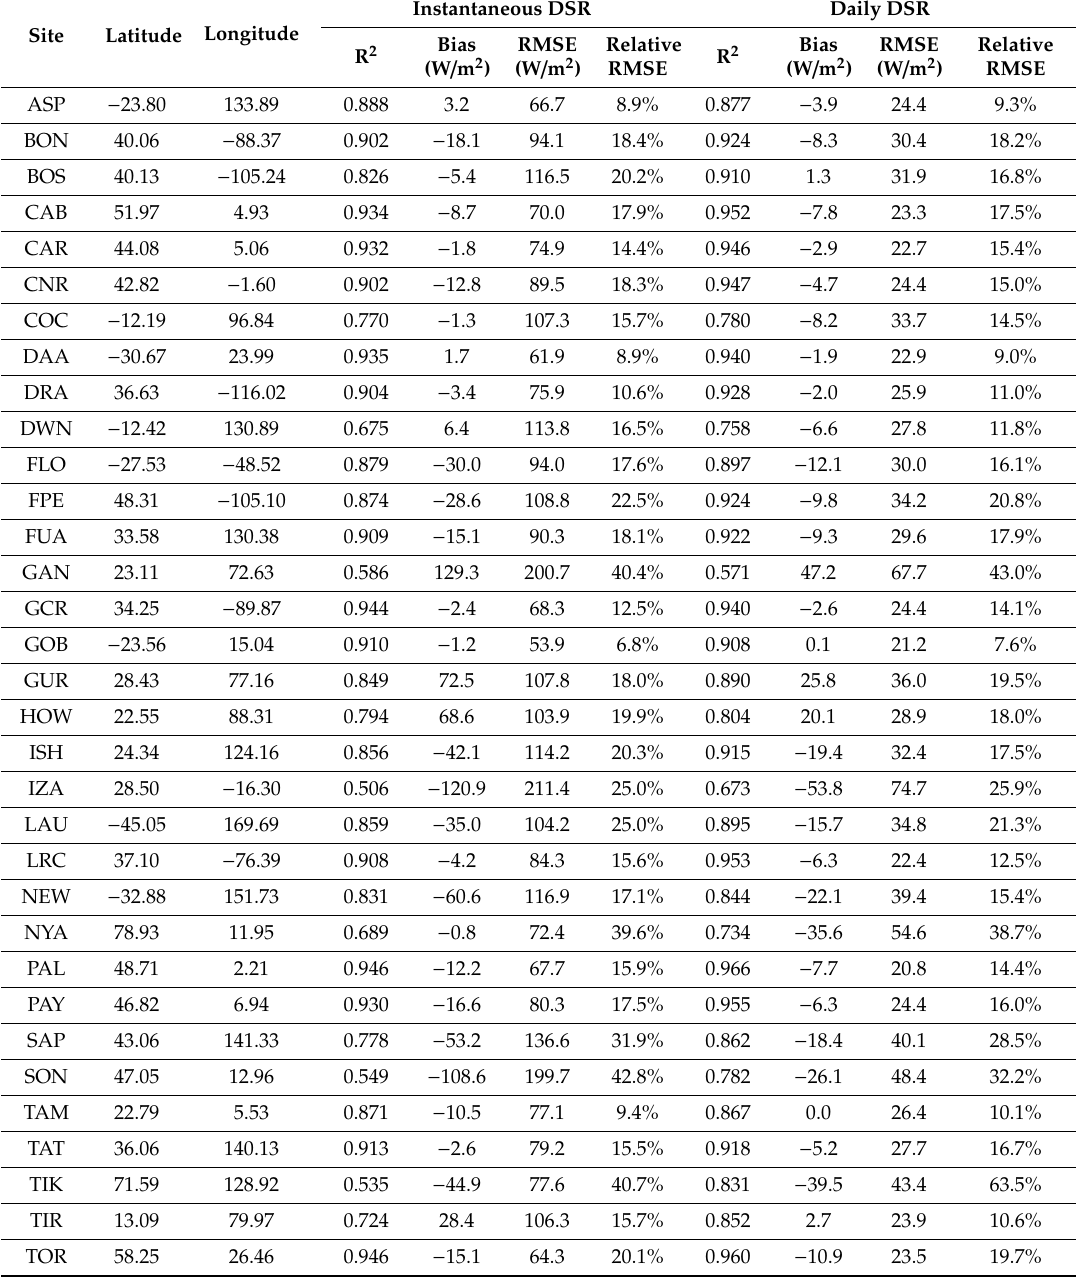
Table 3. Summary of the validation results of instantaneous and daily DSR at each individual Baseline Surface Radiation Network (BSRN)